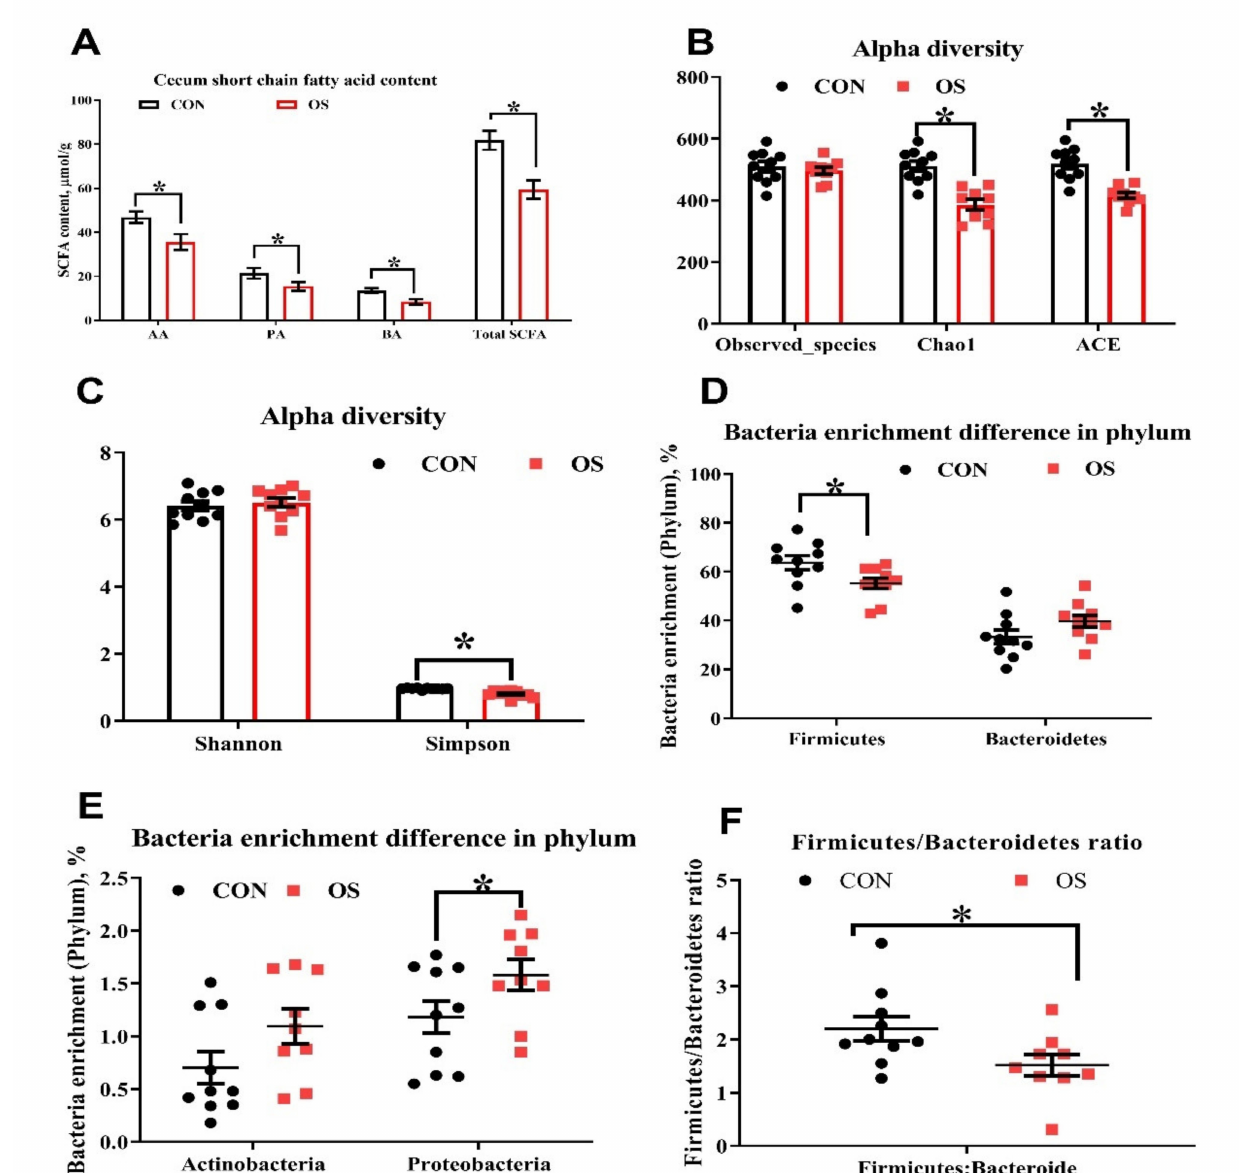
Figure 4. Oxidative stress (induced by tBHP) reduced cecal short chain fatty acid concentration (Experiment 1). Data are means ± SEM represented by vertical bars or plot individual values. ( A ) Short chain fatty acid concentration in cecal digesta. ( B , C ) Alpha diversity of cecum microbiota, with Observed species, Chao 1, ACE ( B ) and Shannon and Simpson index ( C ). ( D – F ). The difference n = 10. Statistical significance was evaluated by the Student’s t -test, * p <